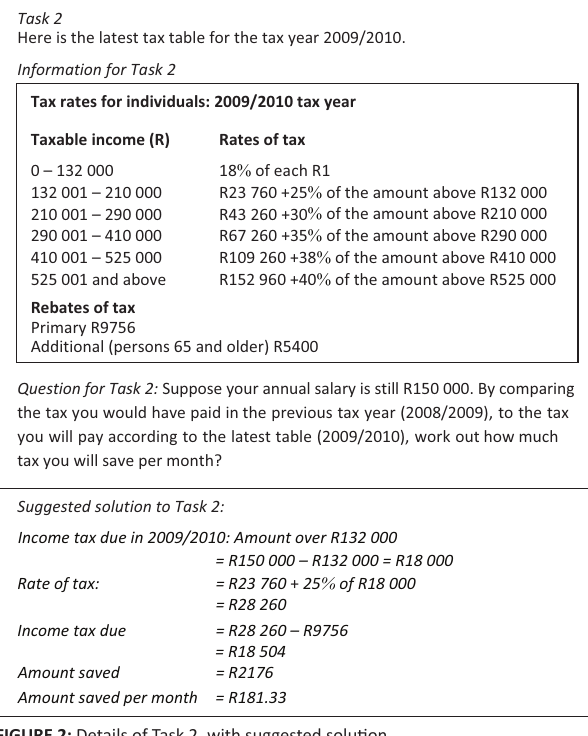
FIGURE 2: Details of Task 2, with suggested solution.